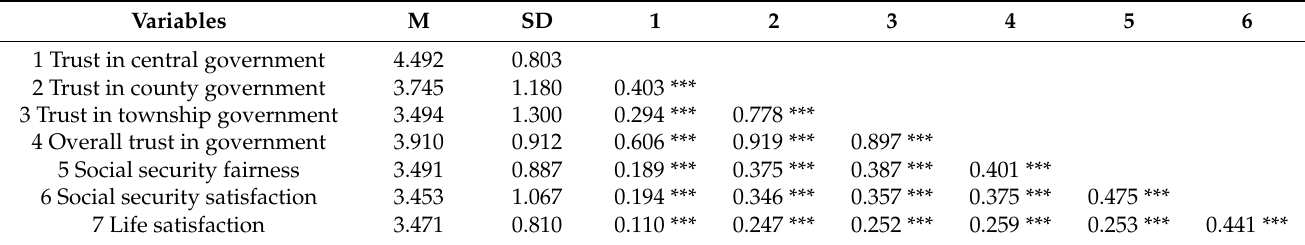
Table 1. Descriptive statistics and correlations among the